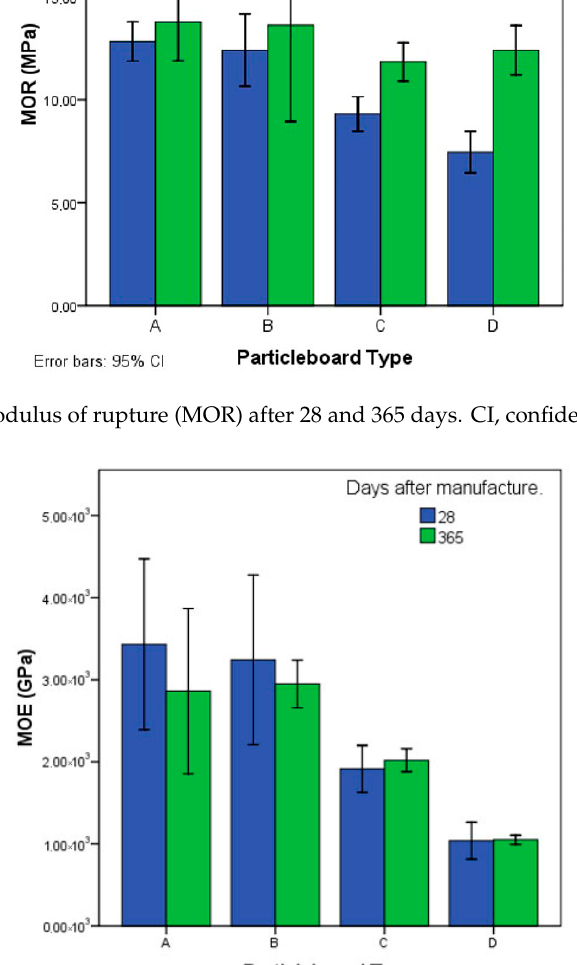
Figure 5. Modulus of elasticity (MOE) after 28 and 365 days. CI, confidence interval.